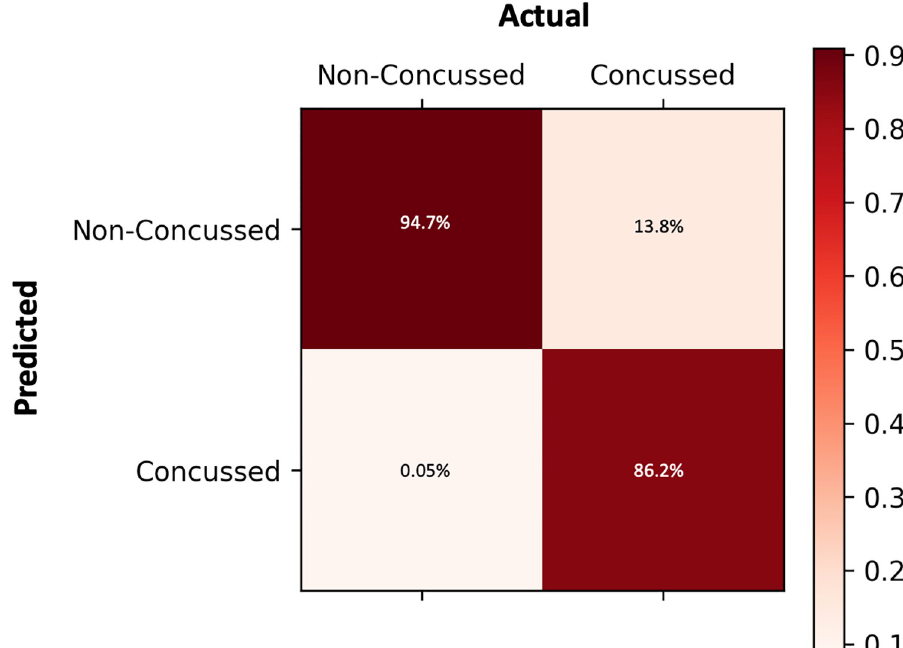
Fig 4. Confusion matrix of the Bi-LSTM-A model classification.